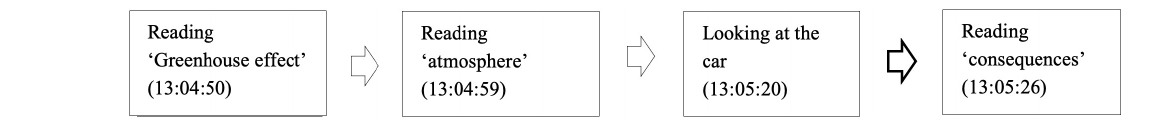
FIGURE 3 | Example of a reading fixation pattern within a mind map.